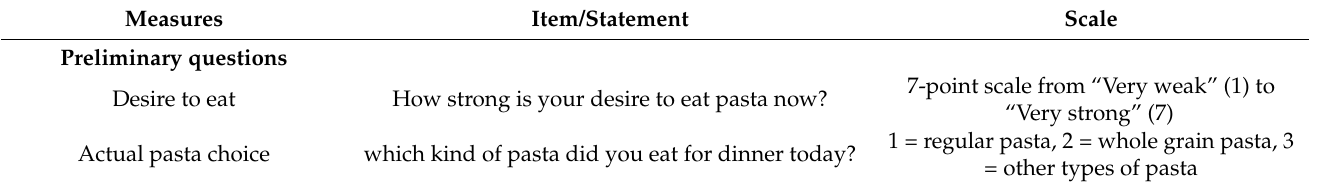
Table A1. Overview of measures used in the